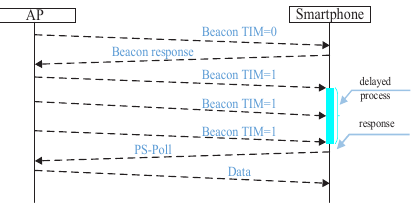
Figure 3. The dealy transmission behavior of router retrieves network packets based on PS-Poll mechanism